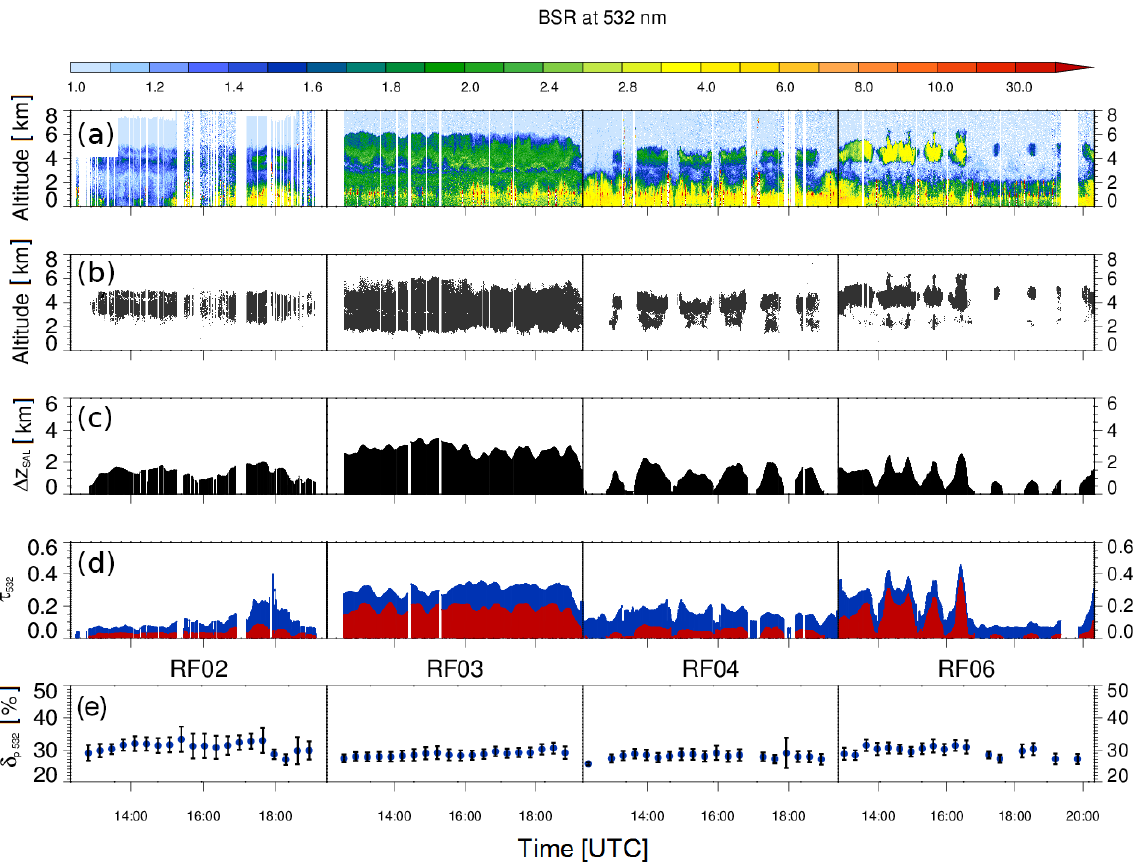
Figure 3. Overview of the four NARVAL-II research flights leading over Saharan-dust-laden trade wind regions. (a) Cross sections of measured BSR at 532nm and (b) applied mineral dust mask. (c) The 10min boxcar average of the calculated dust layer vertical extent (cid:49) z SAL . (d) The 10min boxcar average of the derived total dust aerosol optical depth from aircraft to ground level τ tot ( 532 ) (blue) and aerosol layer optical depth τ SAL ( 532 ) (red). (e) Mean values and standard deviations of the measured 10min averaged SAL particle linear depolarization ratio ( δ p532